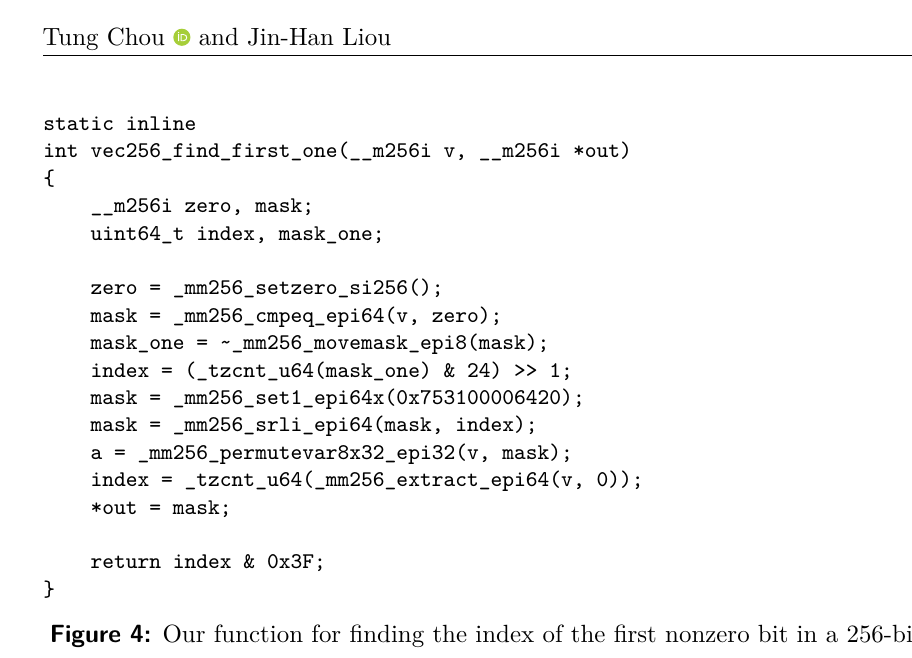
Figure 4: Our function for finding the index of the first nonzero bit in a 256-bit vector. because A p , . . . , A µ are always zero. We can modify the set in Step 5 to t p ` 1 , . . . , µ u